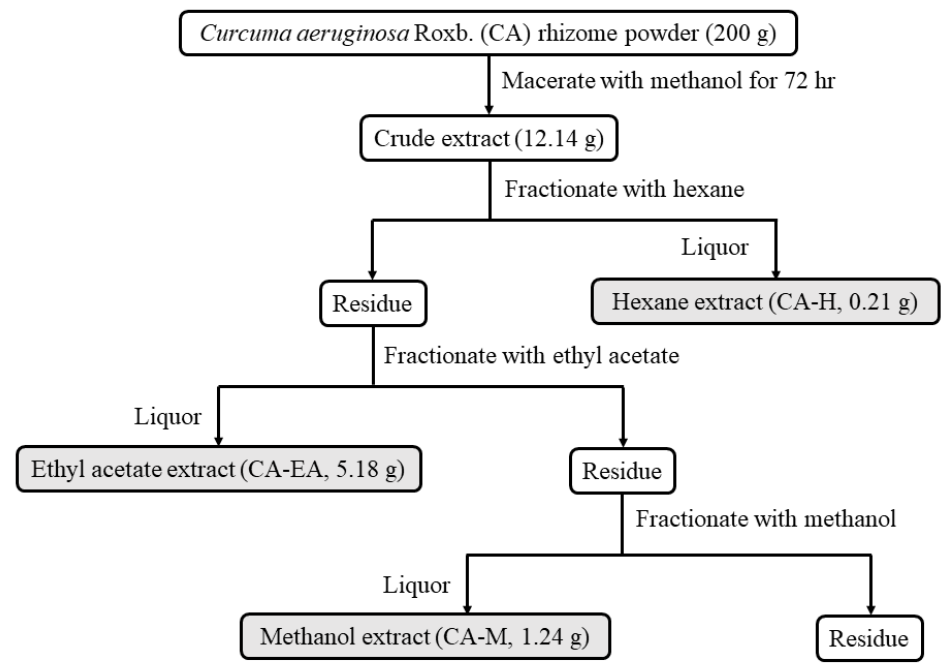
Figure 1. Schematic of Curcuma aeruginosa Roxb. (CA) extraction and fractionation. Rhizomes of Curcuma aeruginosa Roxb. were extracted with methanol then sequentially fractionated with hexane (CA-H), ethyl acetate (CA-EA), and methanol (CA-M), respectively.